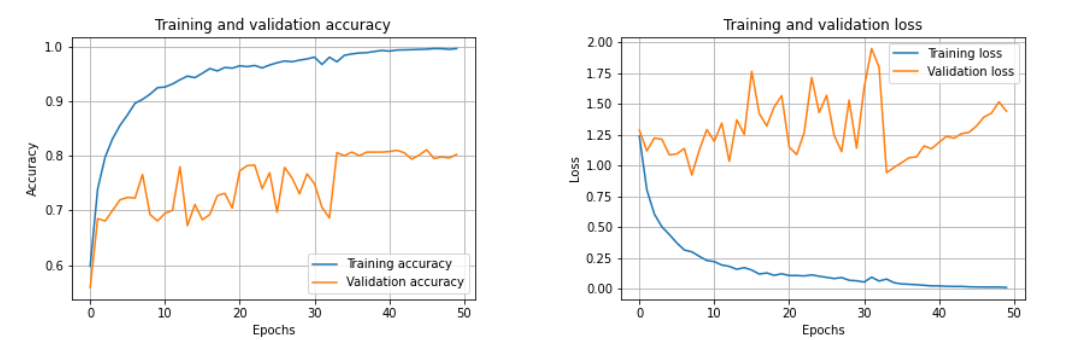
Figure 10. Training and validation accuracy and loss of the selected